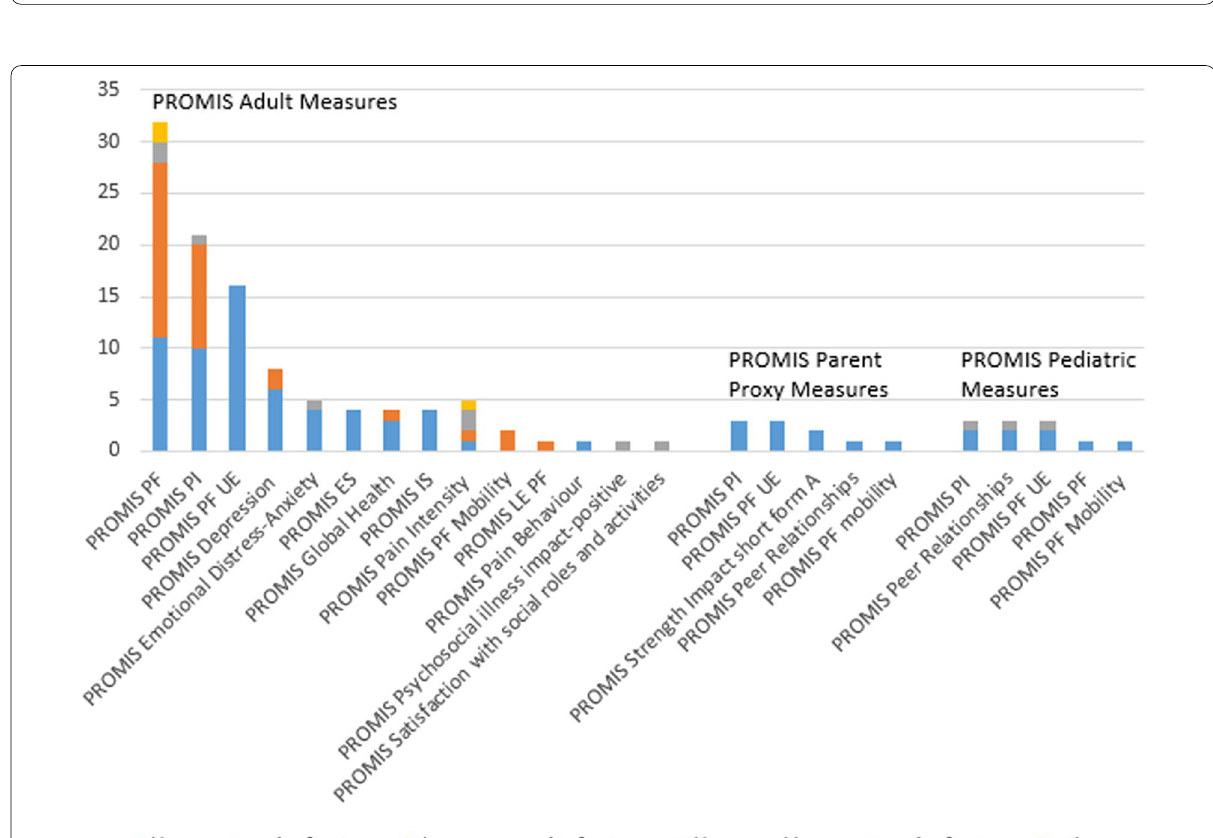
Fig.4 PROMIS measures divided by subgroups for adult PROMIS measures, PROMIS parent proxy measures and pediatric PROMIS measures. PF: Physical Function, PI: Pain Interference, PF UE: Physical Function Upper Extremity, ES: Emotional Support, IS: Instrumental Support, LE PF: Lower Extremity Physical Function, other: not specified if upper or lower extremity